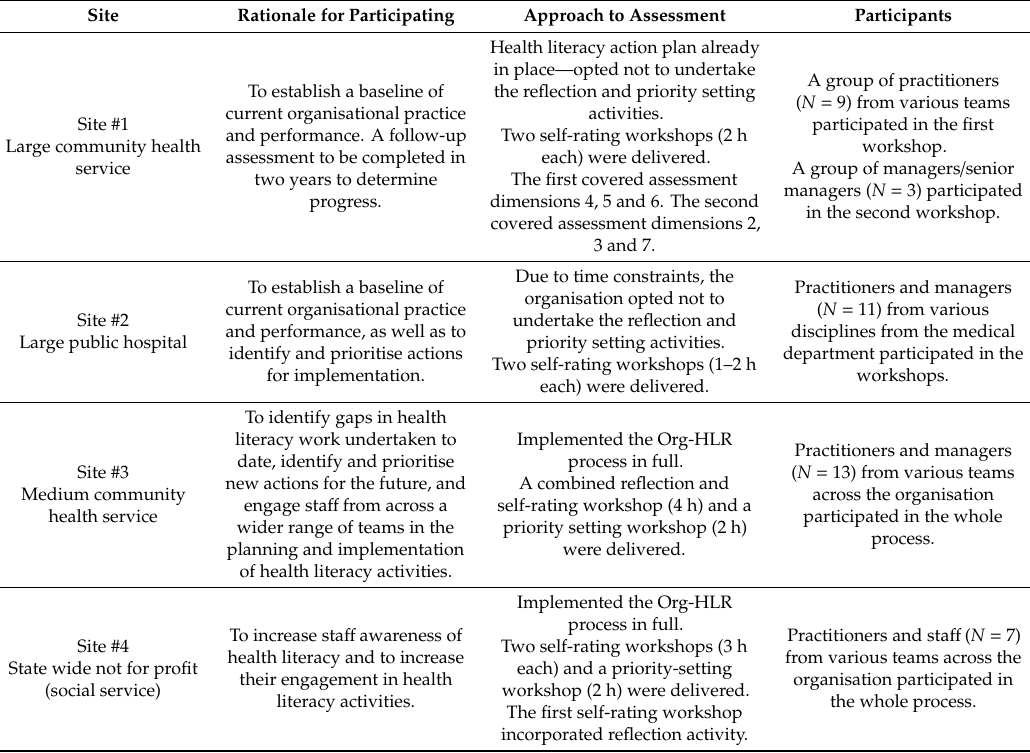
Table 2. Details of the Organisational Health Literacy Responsiveness (Org-HLR) assessment process implemented at each